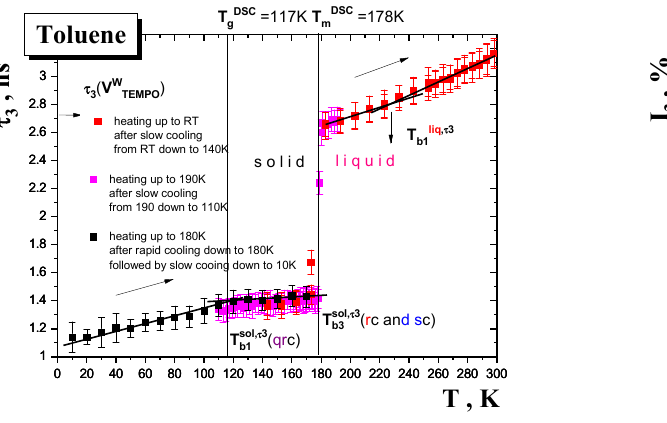
Figure 3. o-Ps annihilation parameters of TOL during various heating runs: (i) heating from 10 K up to 170 K after cooling from RT down to 10 K in 2 h consisting of rapid cooling down to 180 K, i.e., slightly above T mDSC = 178 K, followed by slower cooling in the non-degassed state (black) down to 10 K, (ii) heating from 110 K up to 190 K with 2 and 1 K step after slow cooling (sc) (magenta) with ∆ T = 1 K and (iii) heating from 140 K up to RT K with 5 K and then with 10 K step in the degassed